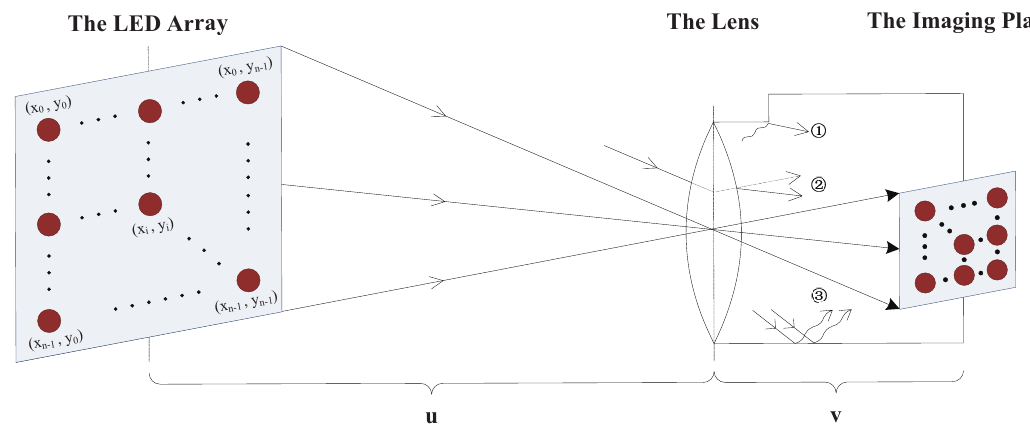
Figure 2. The optical path of the imaging light in the MIMO-IS-VLC system. ( a ) diffraction light at the edge of the grating; ( b ) refraction light from the lens; ( c ) reflection light on the inner wall of the lens’